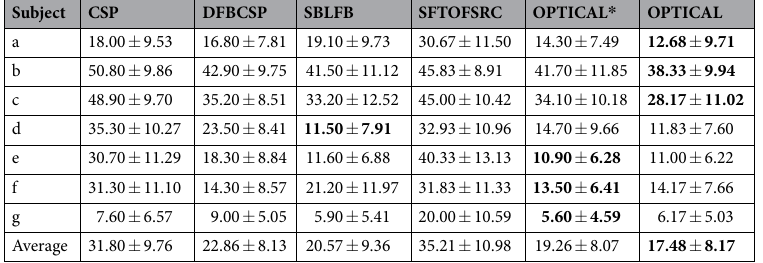
Table 1. Misclassification rate (%) of different methods evaluated using BCI competition IV dataset